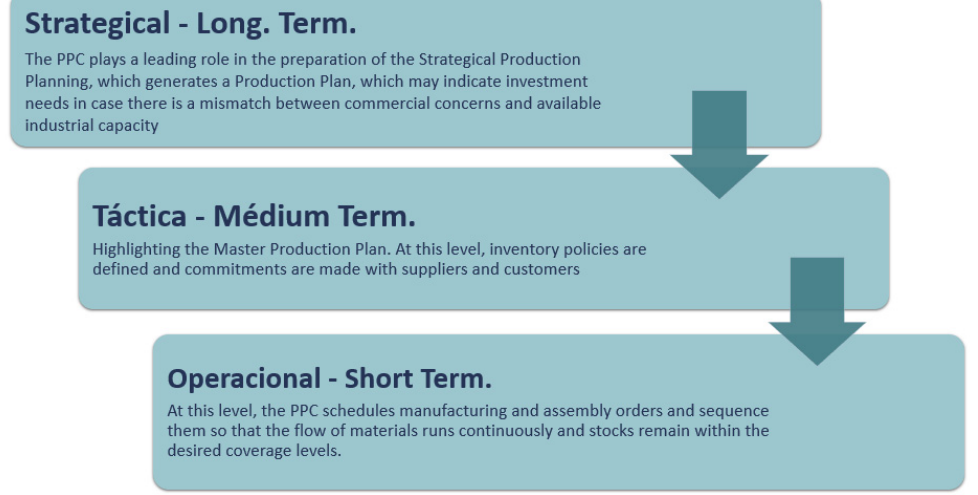
Figure 2. Hierarchical level of activities .